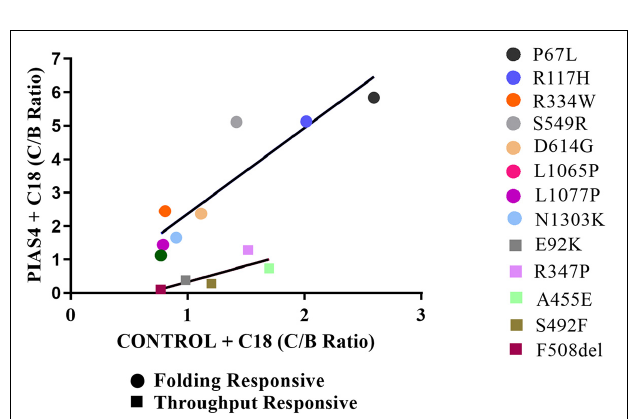
FIGURE 7 | Graphical representation of the groups. C:B ratios for CFTR2 mutants in the folding responsive (circles) and throughput responsive (squares) groups relating values for PIAS4 + C18 to values for C18 alone. The slope of this relation for the throughput responsive mutants was 0.96 and that for the folding responsive mutants was 2.8. Folding responsive: y = 2.6 x – 0.22; R 2 = 0.76. Throughput responsive: y = 0.96 x – 0.62; R 2 =